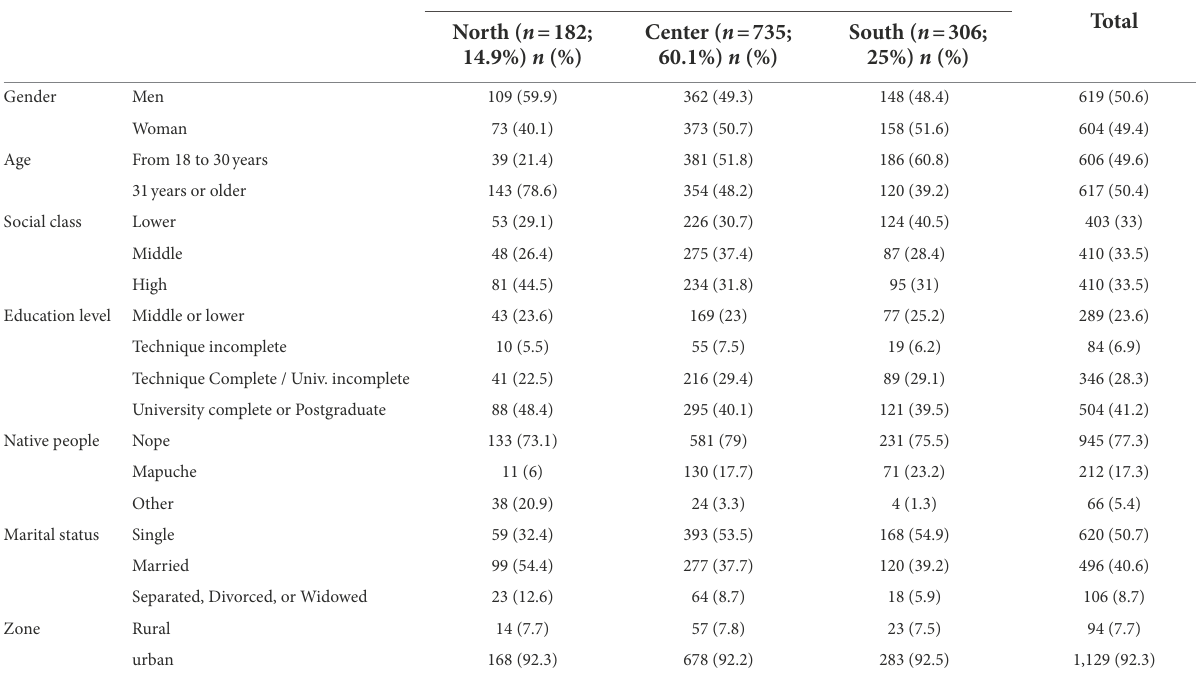
TABLE 2 Descriptive data of the total sample and stratified by country